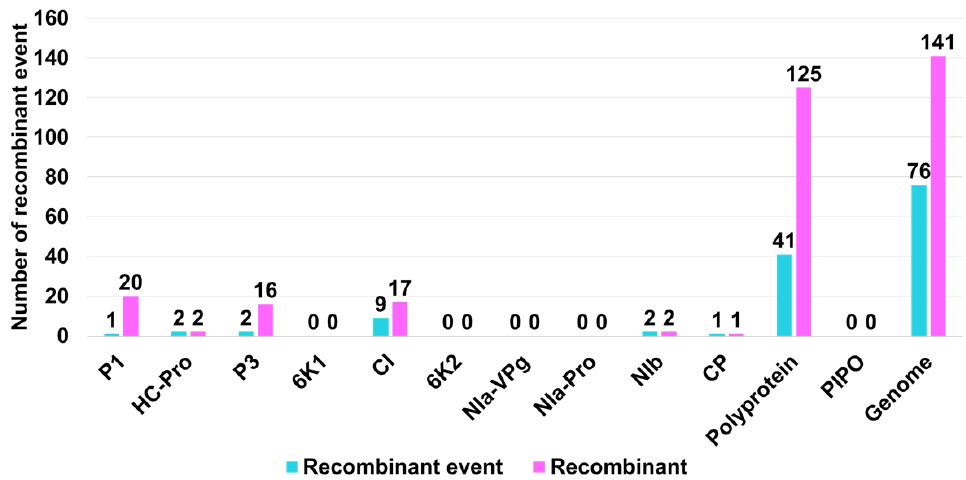
Figure 6. Number of recombinant events and recombinants in individual SMV proteins or